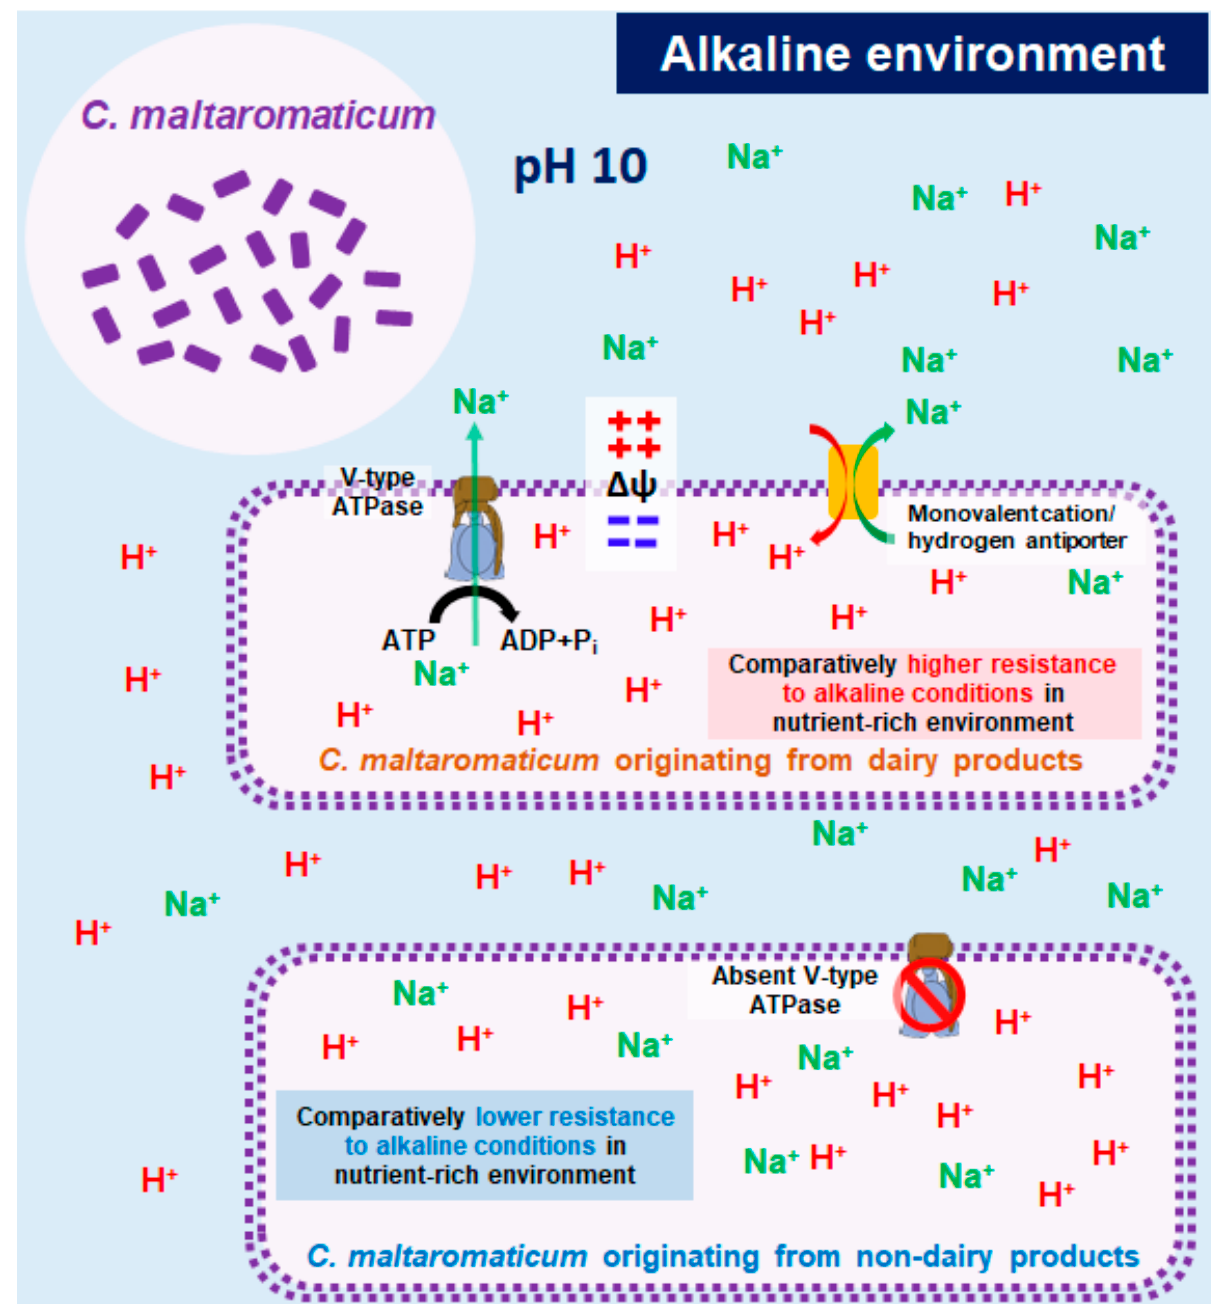
Figure 5. Schematic diagram about the mode of action for V-type ATPase, which only exists in dairy C. maltaromaticum under a highly alkaline environment. ∆ψ indicated the electrical potential in intra- and extra-cellular areas.